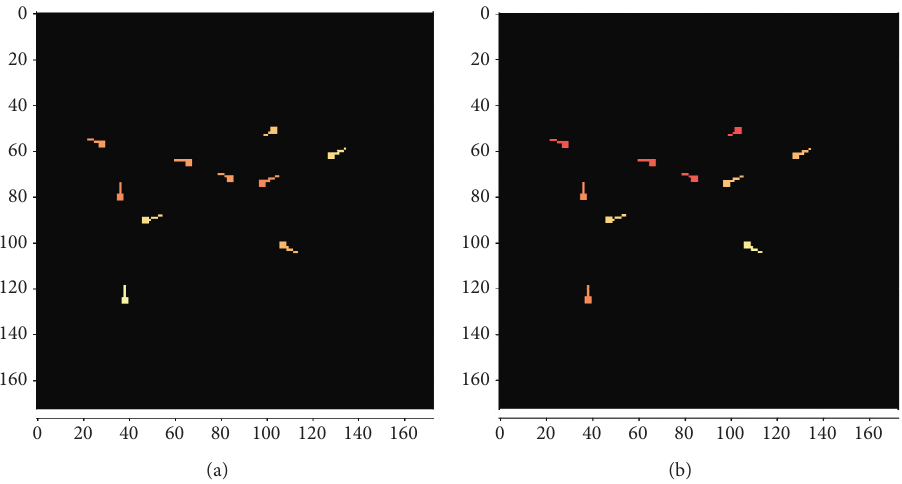
Figure 2: Channels of historical trajectory: (a) altitude channel; (b) speed channel.